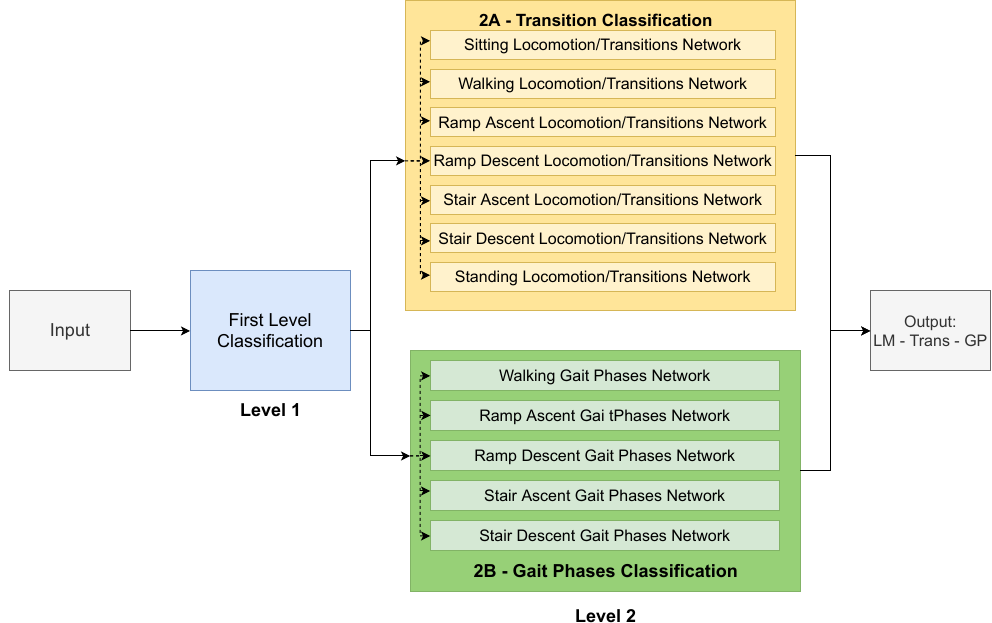
Figure 4. Proposed multi-level architecture for the classification of the locomotion modes, transitions, and gait phases. Level 1 performs a first general classification of locomotion modes, while level 2 distinguishes between locomotion modes and transitions as well as gait